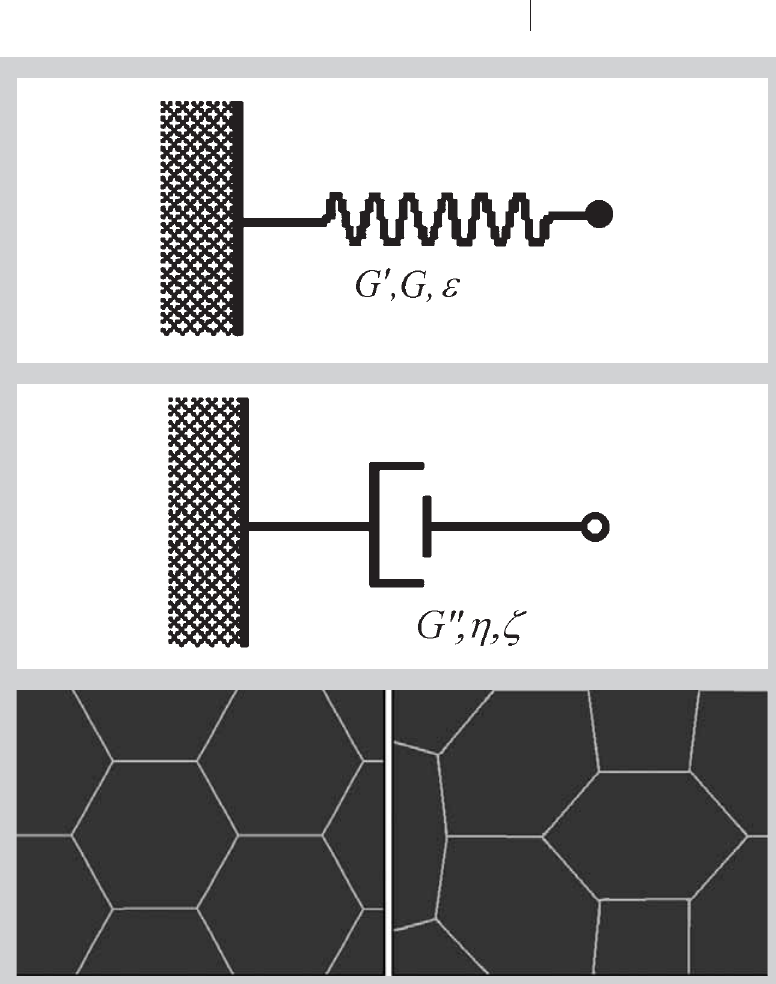
Figure 2 (above/middle): Spring and dashpot as sym- bols for elasticity and vis- cosity, used in 2D and 3D rheology and representing the main rheological quan- tities. Figure 3: Schematic of a complex liq- uid at low and high dis- perse content at low and high shear